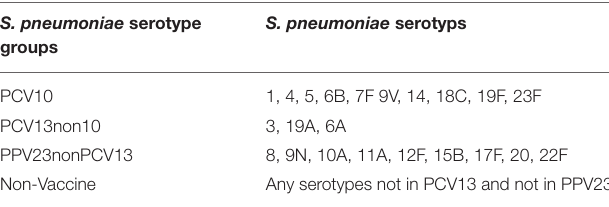
TABLE 2 | Number of IPD cases and average annual IPD incidence by age groups, 2012–2018.